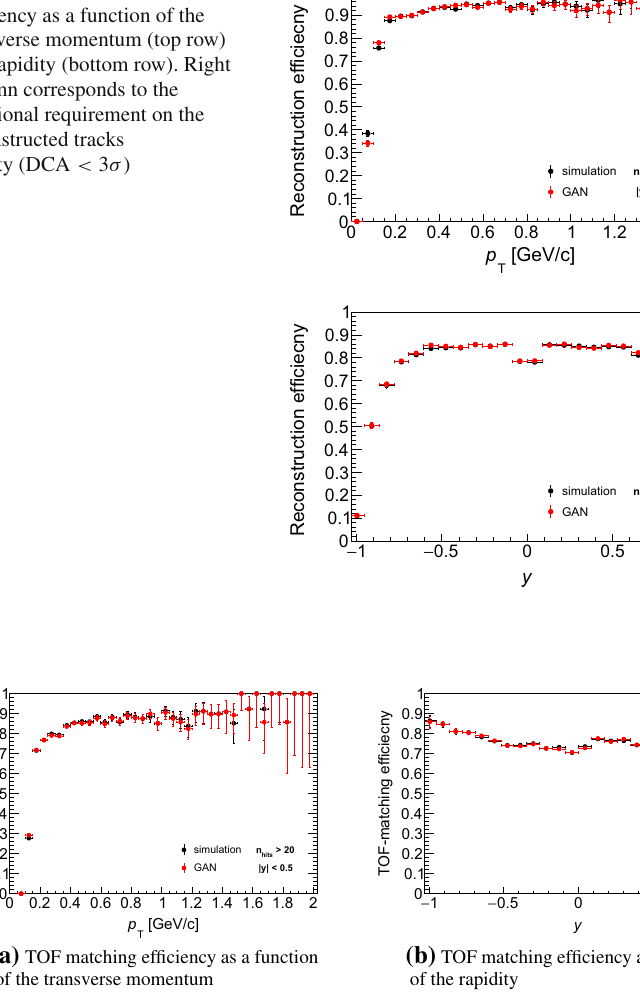
one can use Geant3 energy deposits in the detector mate- rial to scale the predicted integrated amplitude and